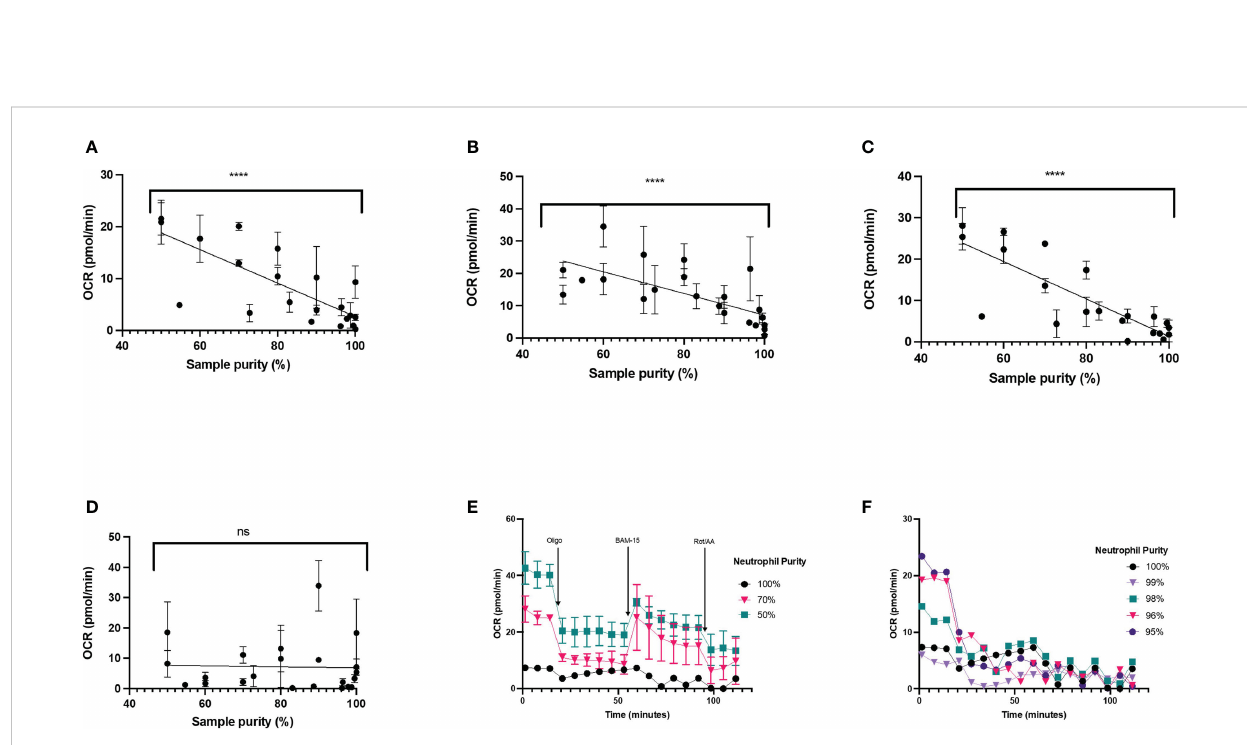
FIGURE 8 Mitochondrial respiration in varying neutrophil purities. Pure neutrophil isolations were contaminated with up to 50% peripheral blood mononuclear cells (PBMCs) harvested from the same donor and cells seeded at 2 x 10 5 /well. Mitochondrial respiration was probed for in neutrophils by sequential injection of 2 µM oligomycin, 3 µM BAM-15 and 2 µM rotenone plus 2 µM antimycin A (Rot/AA). (A) adenosine triphosphate (ATP)-coupled mitochondrial respiration, (B) maximal mitochondrial respiration, (C) basal mitochondrial respiration, (D) non-mitochondrial oxygen consumption, (E) mean oxygen consumption rate (OCR) ± standard error of the mean (SEM) over the duration of the assay, representing 100%, 70% or 50% neutrophil purities from 2 distinct donors and (F) mean oxygen consumption rate (OCR) ± standard error of the mean (SEM) over the duration of the assay, representing 100%, 99%, 98%, 96% and 95% neutrophil purities from a single donor. Data in (A-D) consists of three unique donors, for each donor the cell preparation was intentionally contaminated to achieve 22 samples with varying neutrophil purity between 100% neutrophils and 50% neutrophils. Data points shown are mean ± SEM for four technical replicates for each donor. ns, not signi fi cant; ****, p-value